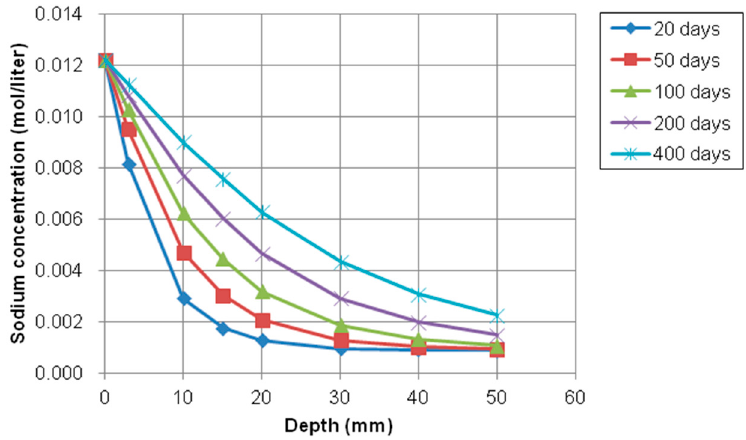
Figure 12. Profile of sodium concentration at different depth over time.